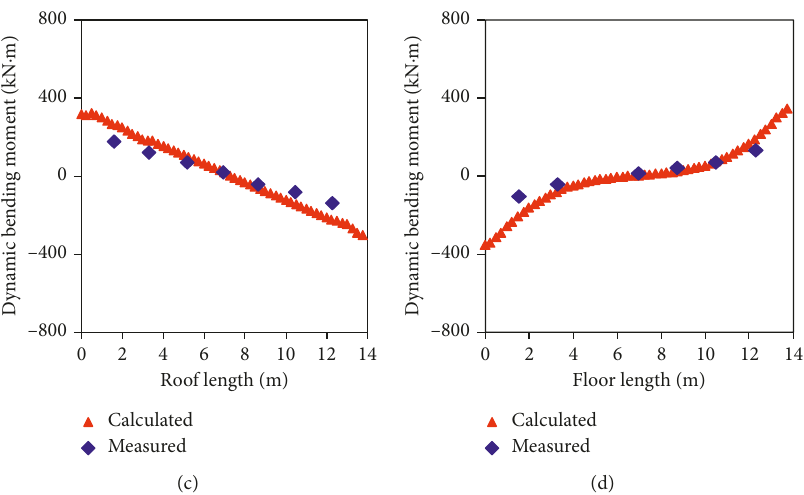
Figure 9: Comparison of measured and calculated dynamic bending moments at maximum thrust. (a) North-side tunnel wall. (b) South-side tunnel wall. (c) Roof slab. (d) Floor slab.